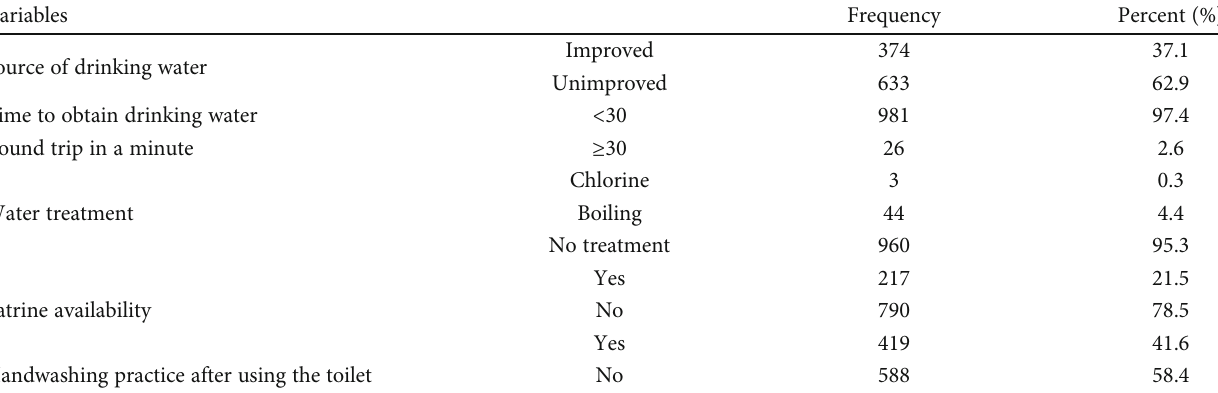
Table 2: Water source and hygienic characteristics among children aged 24-59 months in Lay Armachiho District, Central Gondar Zone, northwest Ethiopia, 2019.